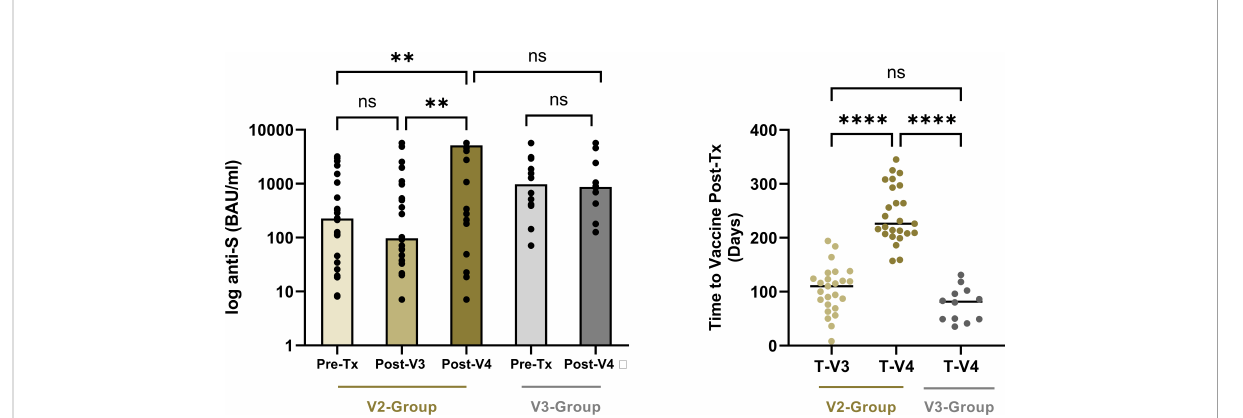
FIGURE 4 Time to booster doses post-transplant and corresponding paired anti-S concentrations in patients who remained infection naïve. In the V2- group, the median time to the 3 rd and 4 th vaccine post-transplant was 110 (73-130) and 226 (208-295) days, p<0.001, and the median anti-S concentrations increased from 97 (34-1074) BAU/ml to 5134 (229-5680) post-V3 and V4 respectively, p=0.0016. For the V3-group, there was no increase in anti-S concentrations from the time of transplant to post-V4, with median values of 981 (396-2666) BAU/ml and 871 (242-2092) and respectively, p=0.62. **p<0.01; ****p<0.0001. ns, non-signi fi